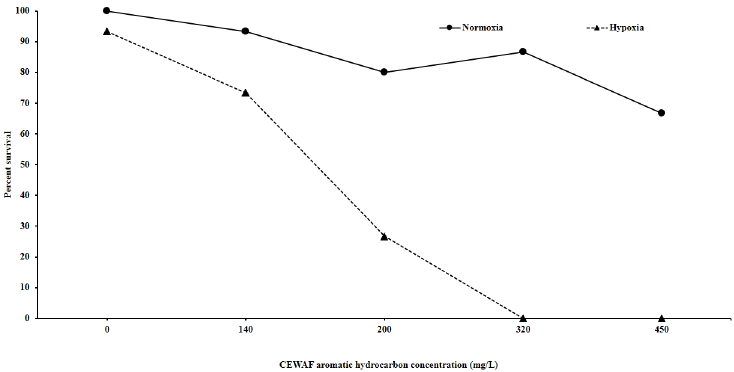
Fig 2. Effects of hypoxia on CEWAF-induced acute toxicity in sheepshead minnow larvae. CEWAF was prepared from Southern Louisiana Sweet Crude Oil and Corexit dispersant. Statistical analysis by 2-way ANOVA demonstrates that both oxygen level and concentration have significant effects on survival (p < 0.001), and there are significant interactive effects between the treatments (p = 0.008).